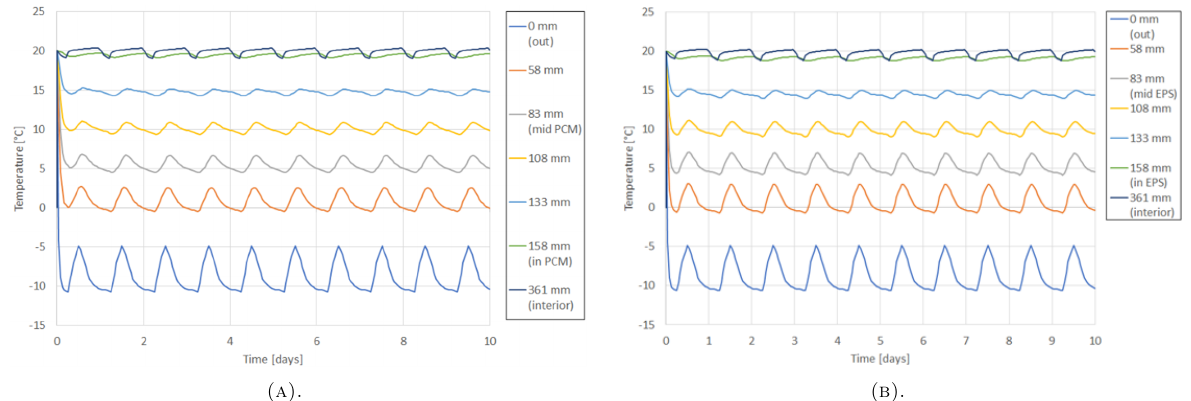
Figure 5. Temperature evolution for EPS (A) and PCM-748 (B) insulation at various distances (see Figure 2) from outer surface for the heating case with the cold conditions.